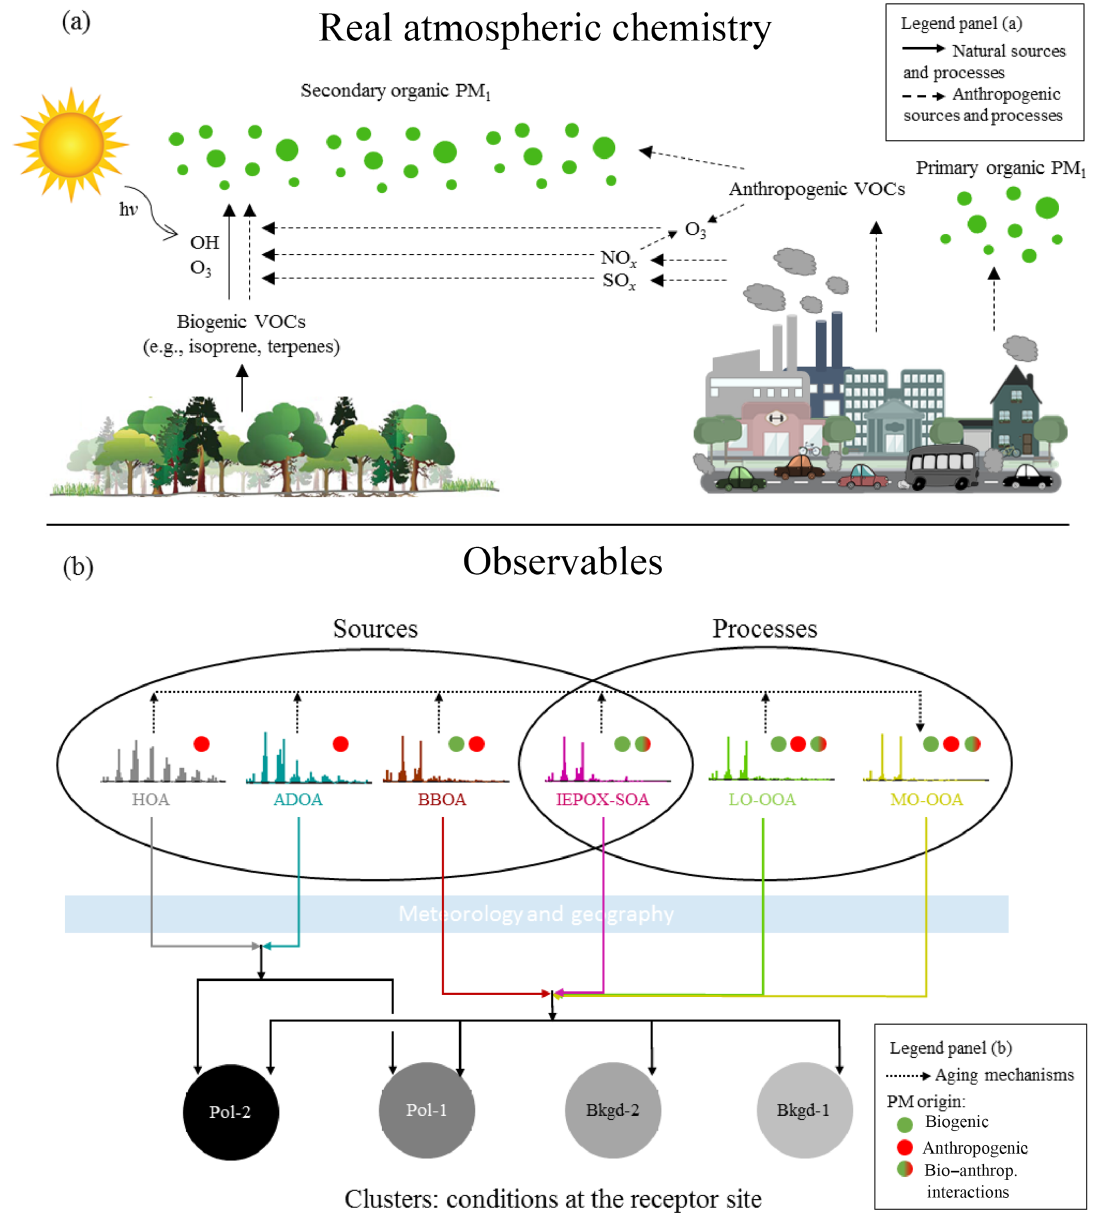
Figure 9. Schematic representation of (a) atmospheric processes, illustrated in a simplified manner, associated with the production of organic PM 1 and (b) observables of these processes as captured by the datasets and analytical approach employed in this study. In panel (a) , the left side depicts the emissions of biogenic volatile organic compounds (VOCs), their atmospheric oxidation, and the production of biogenic sec- ondary organic PM 1 . The right side depicts anthropogenic emissions of gas species and particulate matter that can alter natural atmospheric concentrations and processes. There are primary organic PM 1 emissions from traffic, cooking, and industrial activities. Anthropogenic VOCs can be precursors for the production of secondary organic PM 1 and can affect the production of ozone and hydroxyl radicals. NO x emissions directly and indirectly alter the natural pathways of PM 1 production in the atmosphere. NO x and SO x can also directly contribute to the formation of secondary inorganic PM 1 (not shown), which can in turn play a role in changing pathways of secondary organic PM 1 produc- tion. In panel (b) , different PMF factors represent distinct sources and/or processes. The IEPOX-SOA factor is at the intersection of the two, as it represents both a source (i.e., isoprene emissions from the forest) and a process (i.e., photooxidation under HO 2 dominant conditions, influenced by sulfate concentrations). The dashed black line represents the natural and anthropogenic oxidative processes that transform the chemical signature of the HOA, ADOA, BBOA, IEPOX-SOA, and LO-OOA factors after sufficient atmospheric residence time into the MO-OOA factor. The clusters represent different conditions at the receptor site (i.e., T3); therefore, they incorporate the meteorological and geographical histories of the air masses that reach the site and affect the observed concentrations. The different PMF factors are associated to the different clusters (solid lines) to various extents (not detailed here for simplification purposes; cf. Fig.